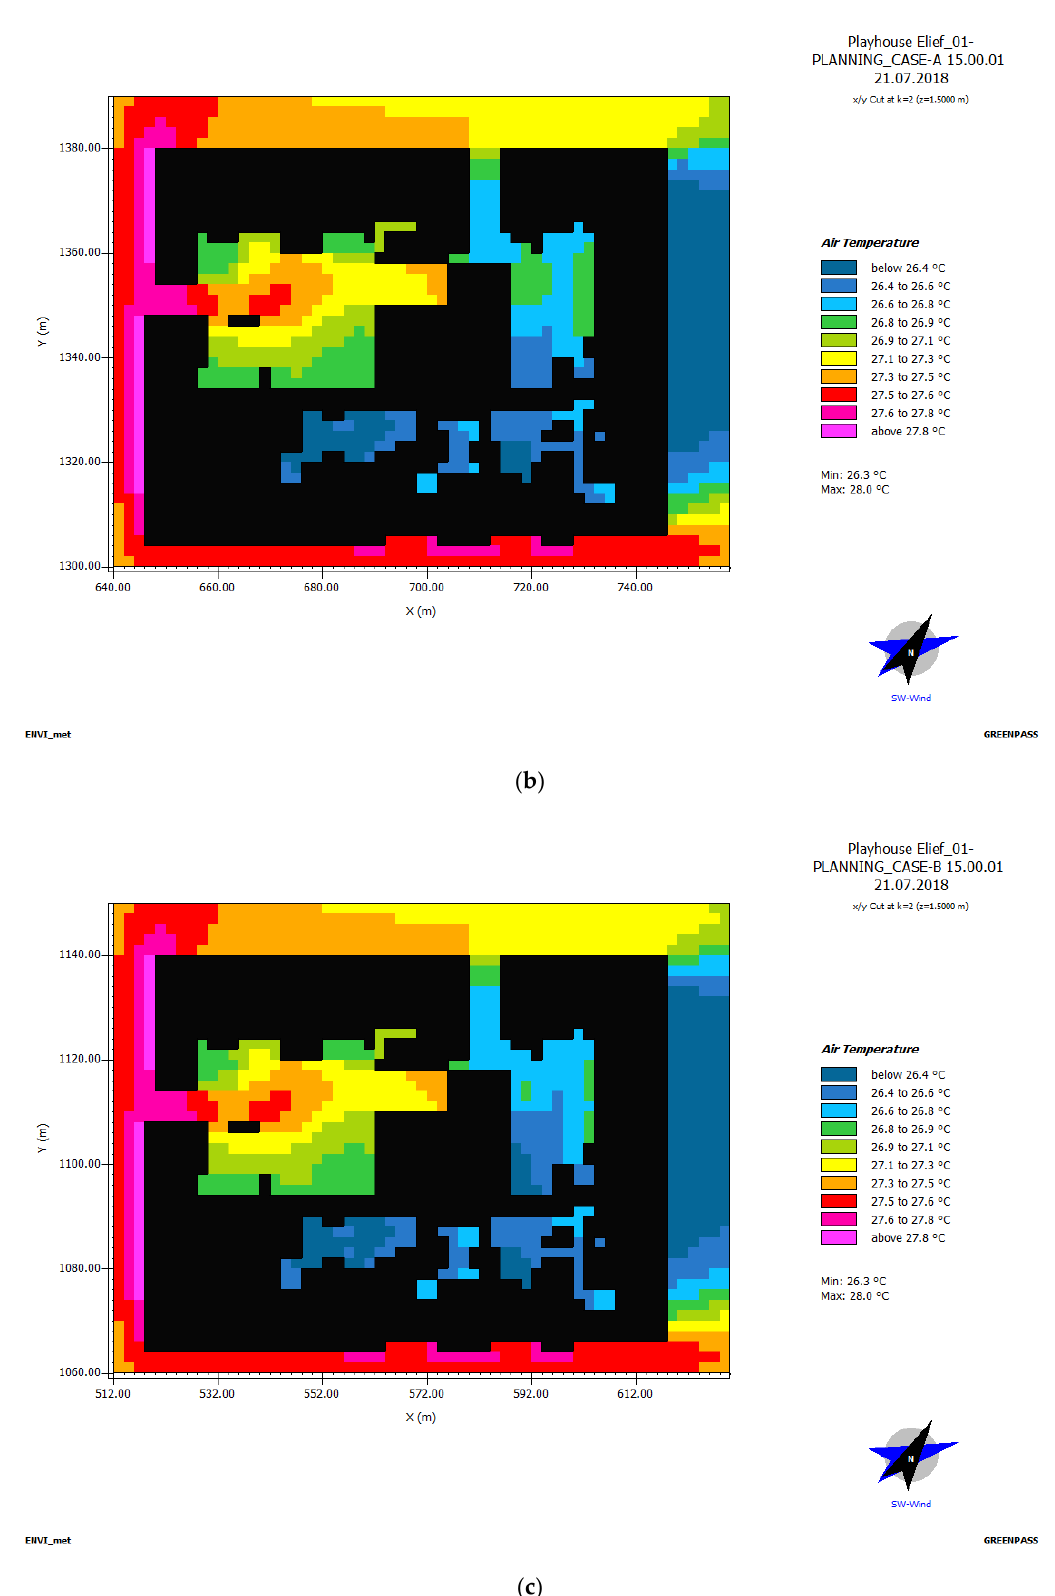
Figure 5. Results of microclimate simulation—Playhouse Elief Antwerp, comparison on a hot summer day 21.07. ( a ) Variant SQ—air temperature 15:00 at ground level; ( b ) Variant A—air temperature 15:00 at ground level; ( c ) Variant B—air temperature 15:00 at ground